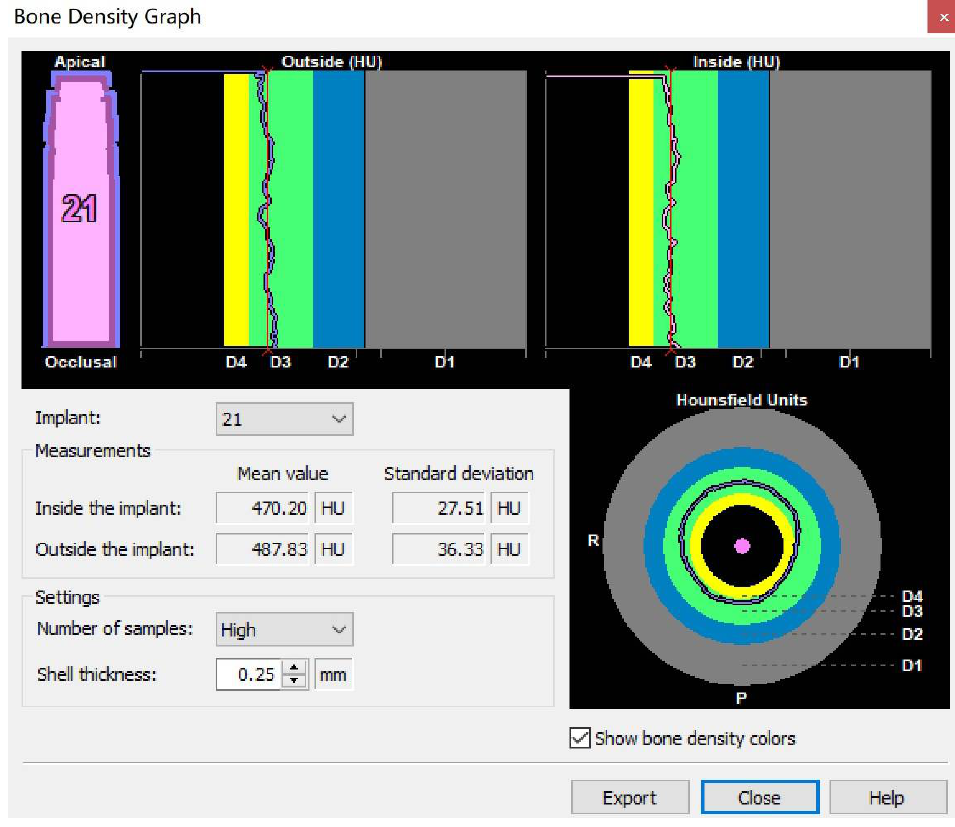
Figure 3. The bone density graph: The shell thickness was set to be 0.25 mm, and the number of samples was high. The mean Hounsfield unit (HU) value of outside the implant could be taken for the bone